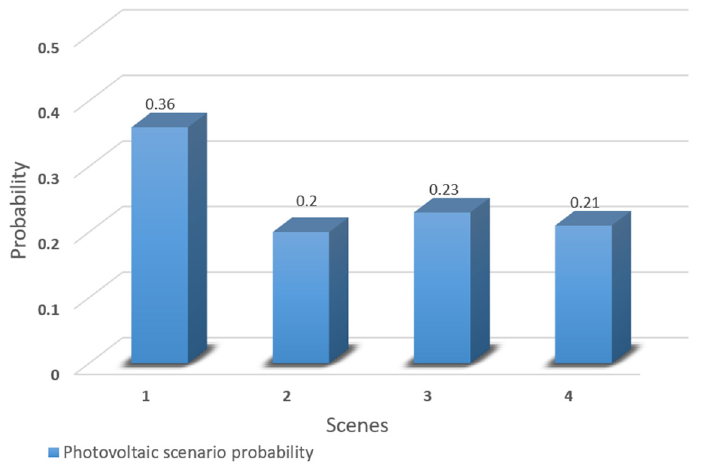
Figure 6. The probabilities corresponding to each photovoltaic classic scenario.